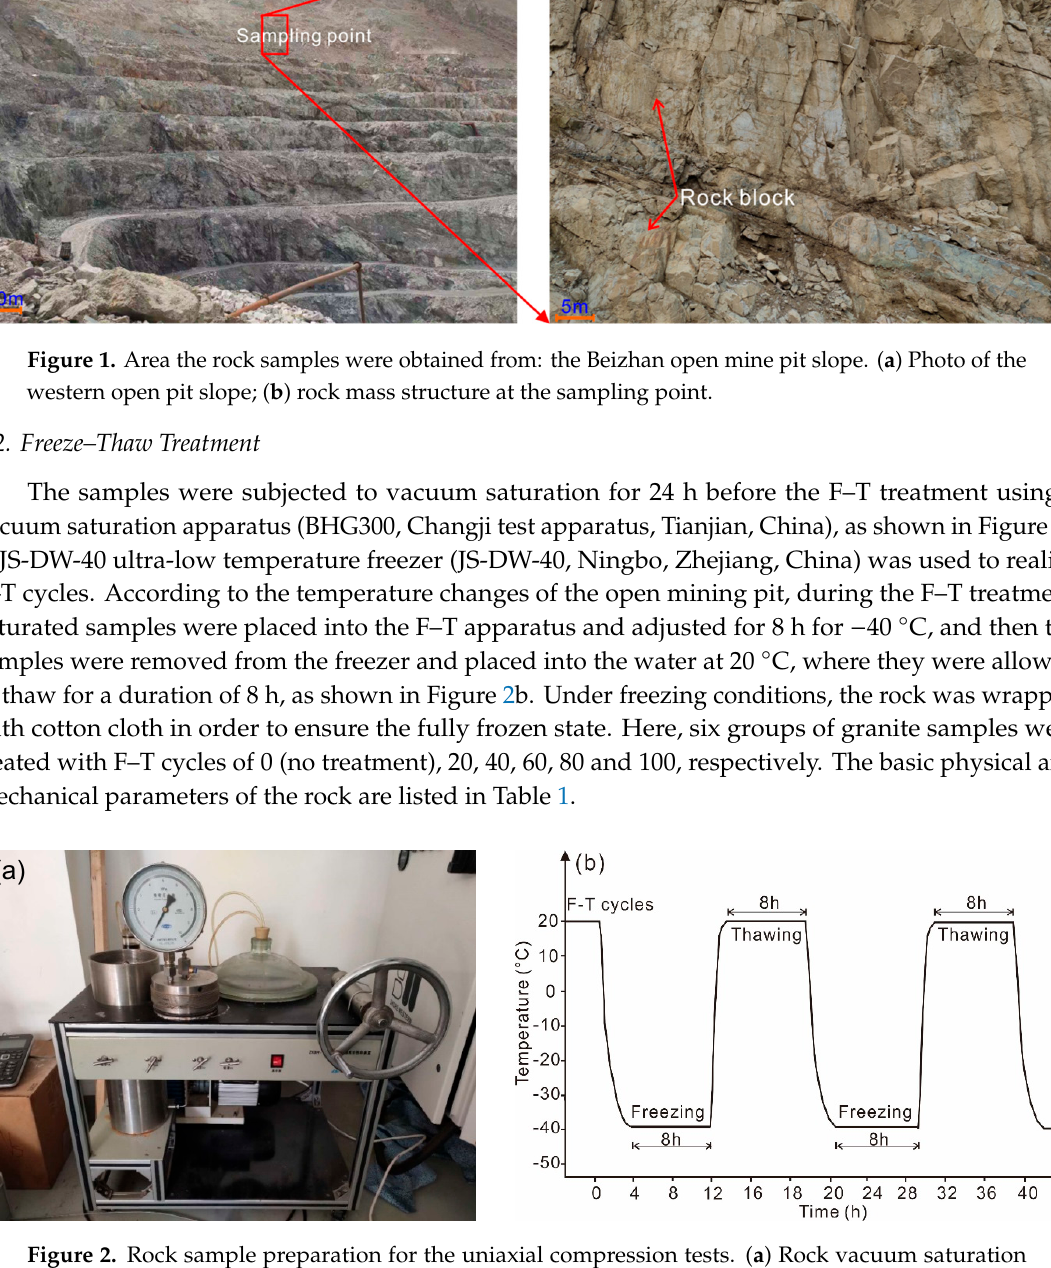
Figure 2. Rock sample preparation for the uniaxial compression tests. ( a ) Rock vacuum saturation apparatus; ( b ) method of rock freeze–thaw treatment.